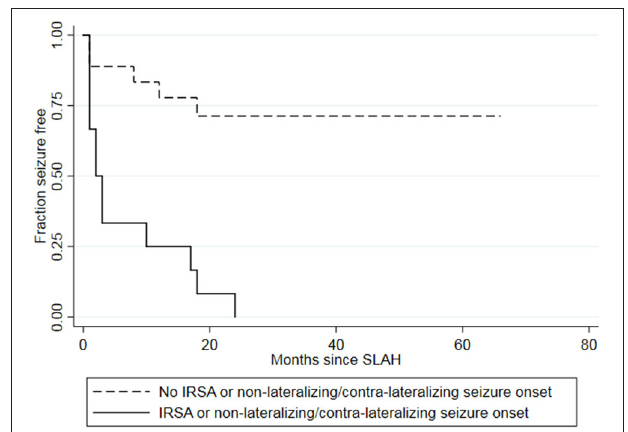
FIGURE 3 | Kaplan-Meier survival curve showing longer seizure freedom for the group of patients without either IRSA or non- or contra-lateralizing seizure onset (dashed lines) than for the group of patients with either IRSA or non- or contra-lateralizing seizure onset (solid line). Two patients had both IRSA and a non- or contra-lateralizing seizure onset on EEG. IRSA, interictal regional slow activity; SLAH, stereotactic laser